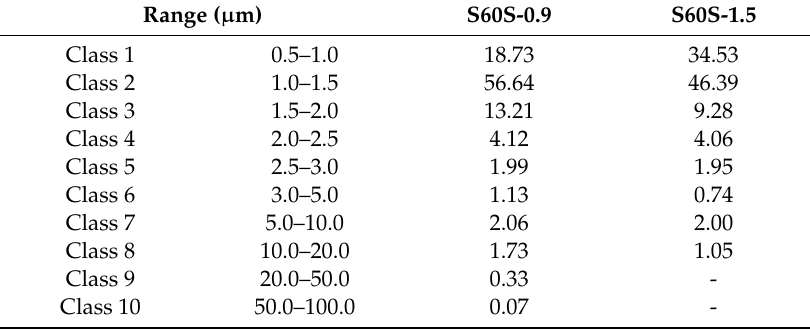
Figure 2. Field emission scanning electron microscope (FE-SEM) images of vulcanizates: ( a1 ) S60S-0.9 ( × 1000), ( a2 ) treated image of a1 , ( b1 ) S60S-1.5 ( × 1000), and ( b2 ) treated image of b1 . Table 6. Agglomerate size distribution of silica in vulcanizates by sulfur variation.